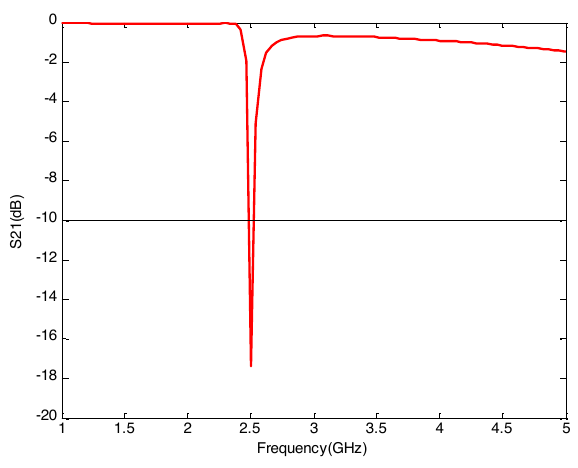
Fig.4 Retrieved effective parameters of the proposed – MTM. (a) permeability, (b) permittivity